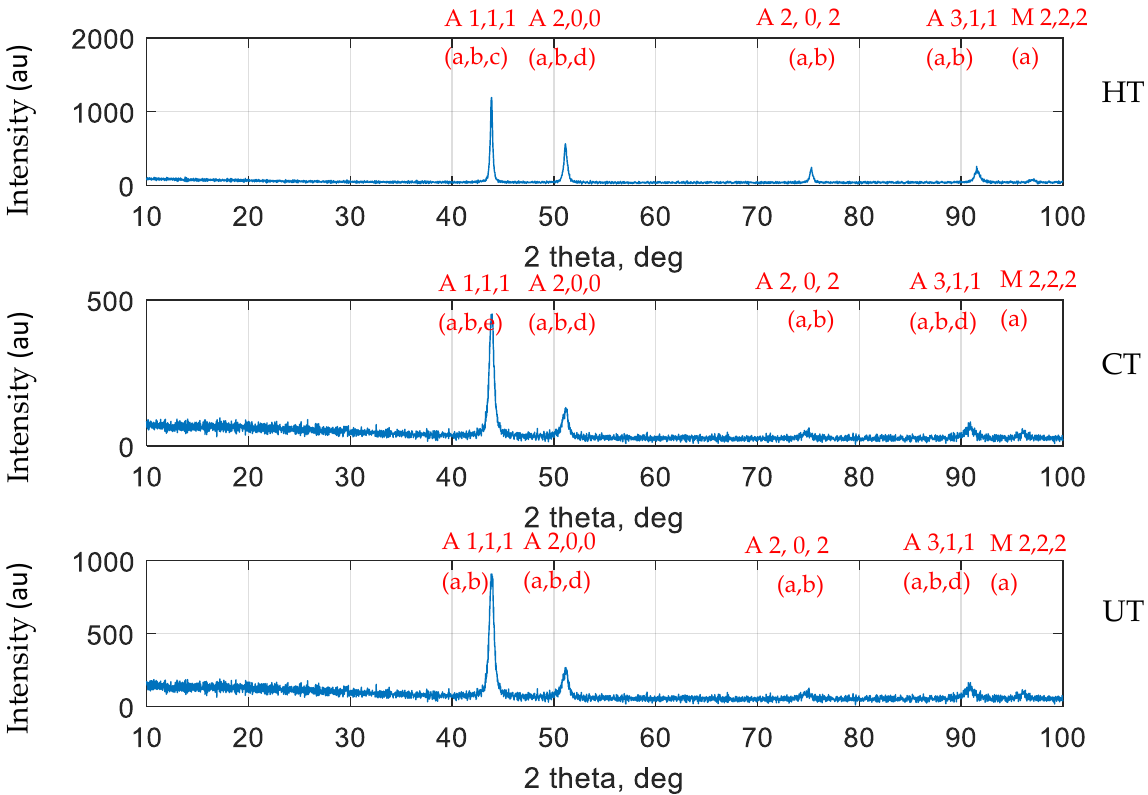
Figure 3. XRD failure region analysis for all specimens at SS 316L HAZ.